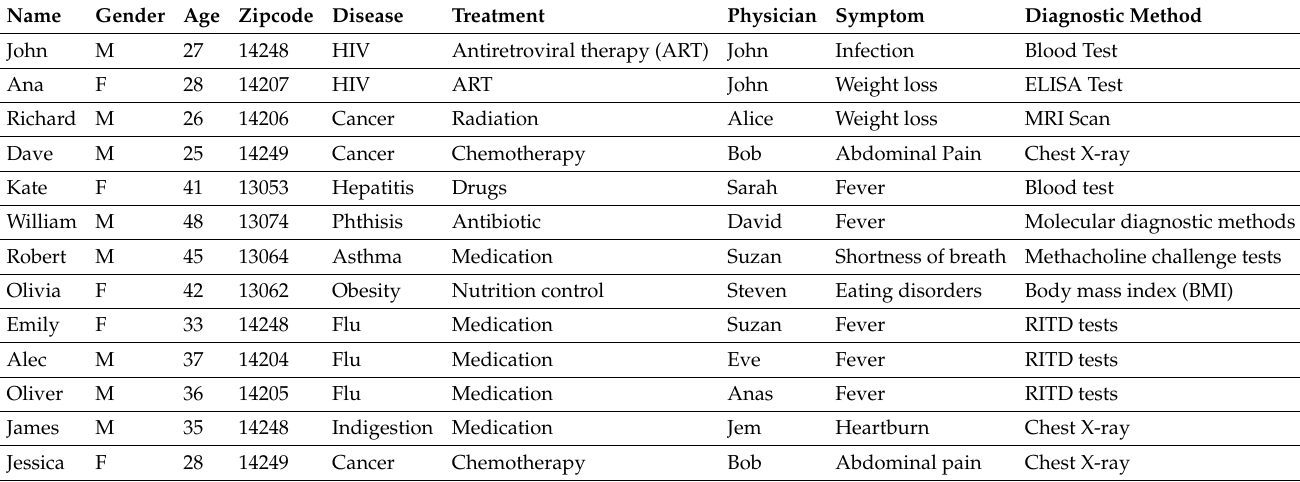
Table 1. Original data table.